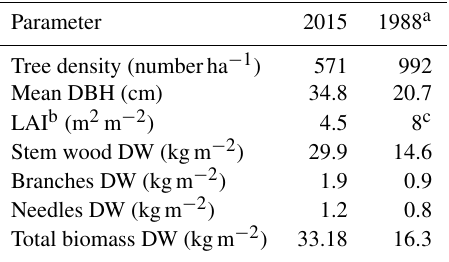
a Biomass dry weight values were estimated using tree density and DBH from Tiktak and Bouten (1994). b LAI measured by using the LI-COR-2000 instrument. c Previous studies in Speulderbos report a LAI of 11: that value was estimated by the destructive method (cf. Heij and Schneider, 1991). For comparative reasons, we use the reported value using the LI-COR